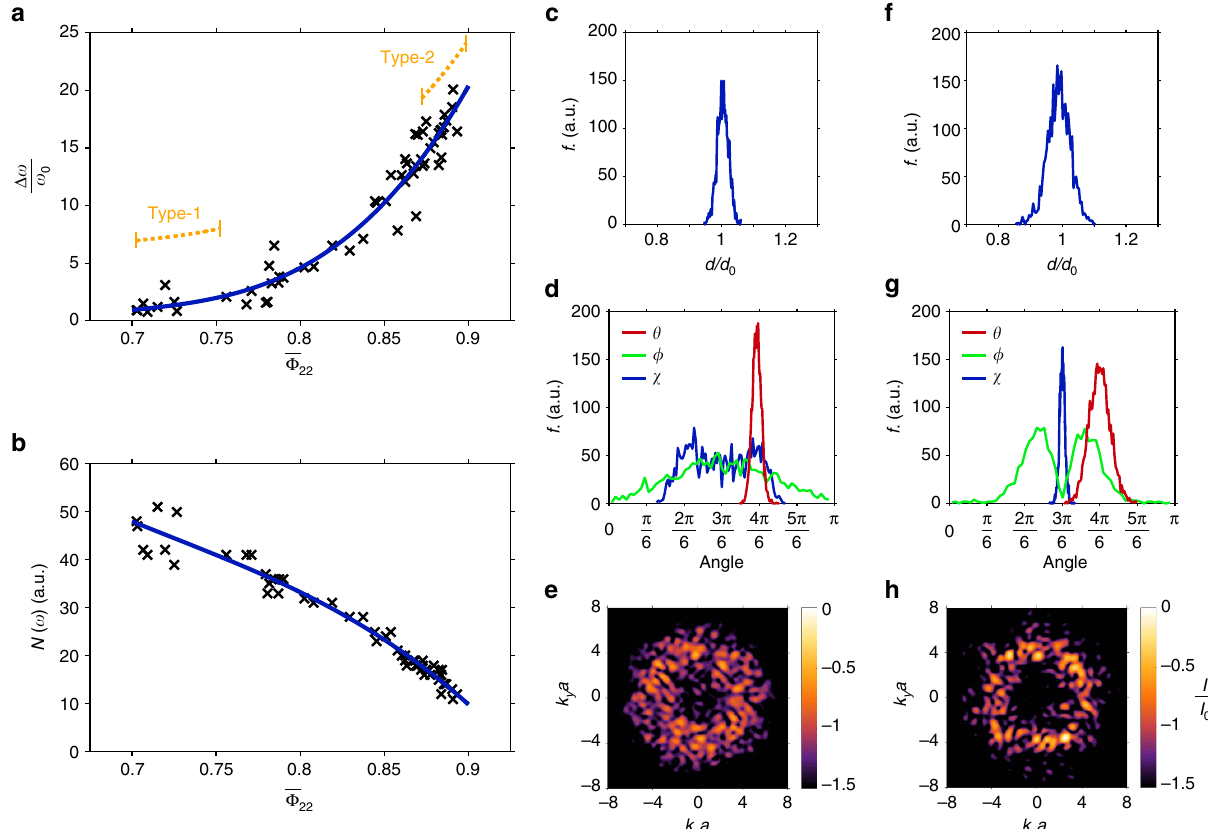
Figure 4 | LSU and PBG forming ability. The LSU of amorphous gyroid networks, as measured by the mean of their F 22 distributions, is strongly correlated with PBG width ( a ). Similarly, the integrated DOS N ( o ) decreases smoothly with increasing F 22 ( b ). Fit lines (cubic polynomials) are for visualization purposes only. Approximate LSU regions for type-1 and type-2 networks are indicated ( a , orange). We present also the edge length frequency ( f ) distributions ( c , f ), inter-edge ( y ), dihedral ( f ) and skew ( w ) angle frequency distributions ( d , g ) and structure factor slices ( e , h ) for typical type-1 and type-2 networks, respectively. Structure factor intensities I are plotted on logarithmic colour scales and data in both panels is normalized to the maximum intensity I 0 of h